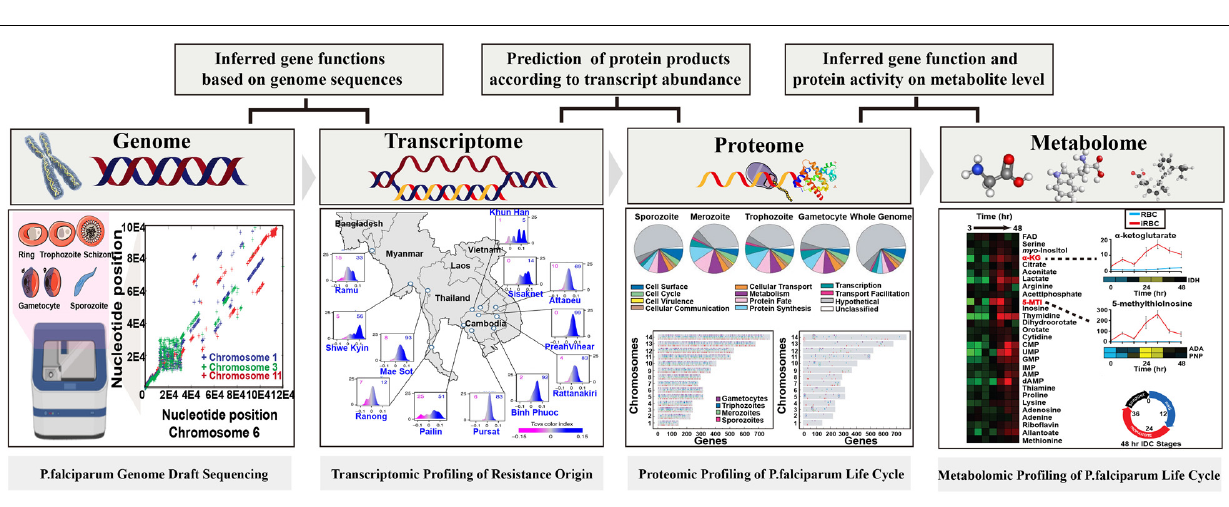
Frontiers in Microbiology | www.frontiersin.org